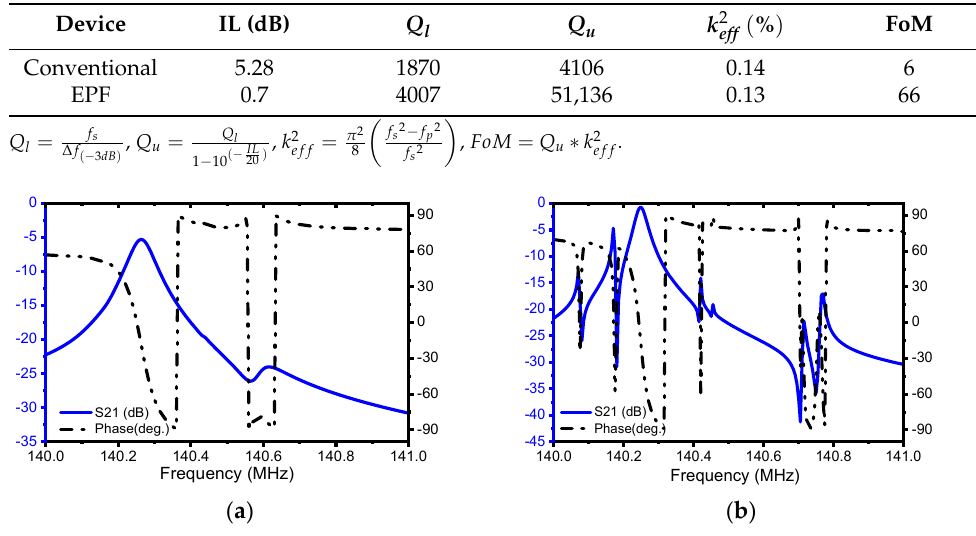
Figure 6. Illustration of the simulated admittance, Y11 (dB), and conductance, G (dB), response of the: ( a ) conventional resonator and ( b ) EPF resonator. Table 2. Summary of the simulated results.